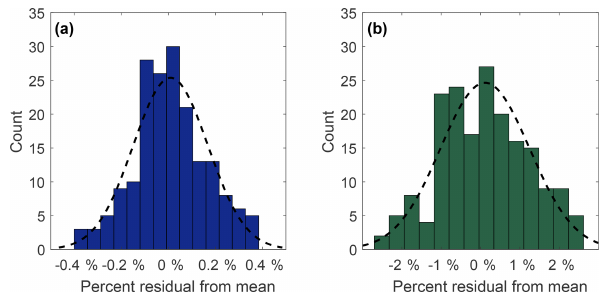
Figure 3. Measurement precision for N 2 O (a) and SF 6 (b) ex- pressed as percent relative standard deviation from 30 sets of 6 mea- surements of the NOAA reference gas. The black dotted line repre- sents a normal distribution curve with the same mean and standard deviation. The standard deviation for N 2 O and SF 6 is 0.16% and 1.1%,